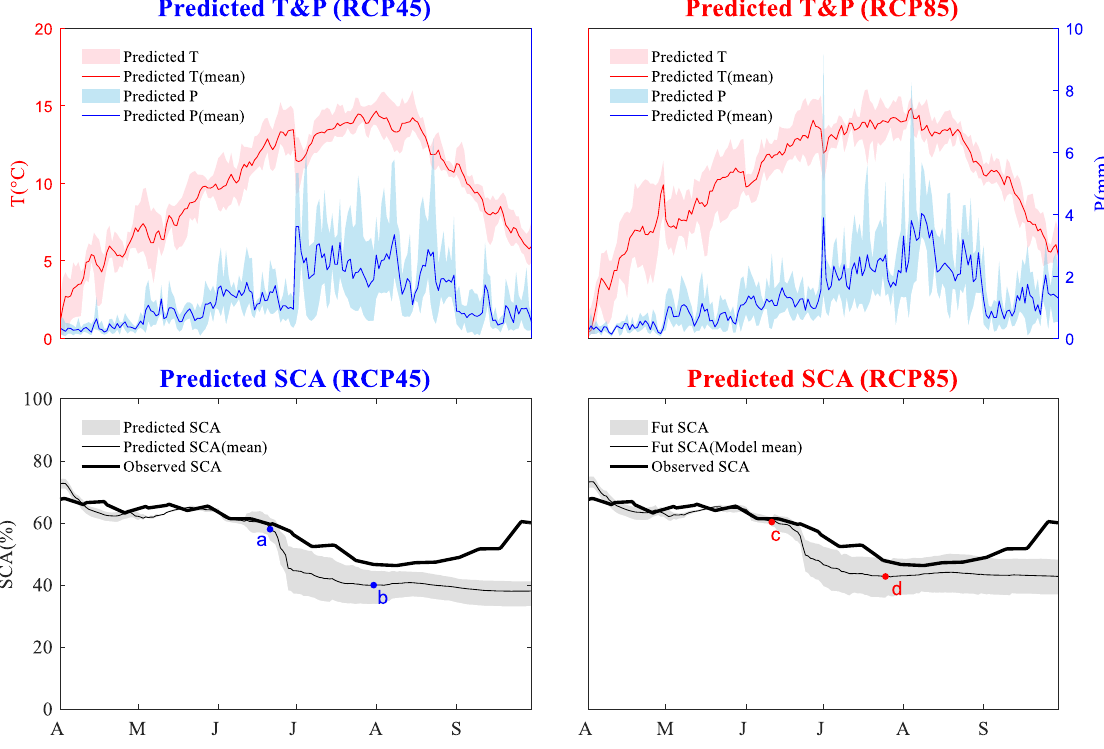
Figure 7. Projected mean monthly temperature (T), precipitation (P) and snow coverage area (SCA) (Period 2041–2050) compared with observations (Period 2003–2012). The pink shading represents the four chosen GCMs, whose mean value is represented by the red line. The same representation is used for the precipitation, indicated in blue. a represents (June 21st, 58.0%), b represents (July 31st, 40.1%), c represents (June 11st, 60.3%), d represents (July 25th, 42.8%).